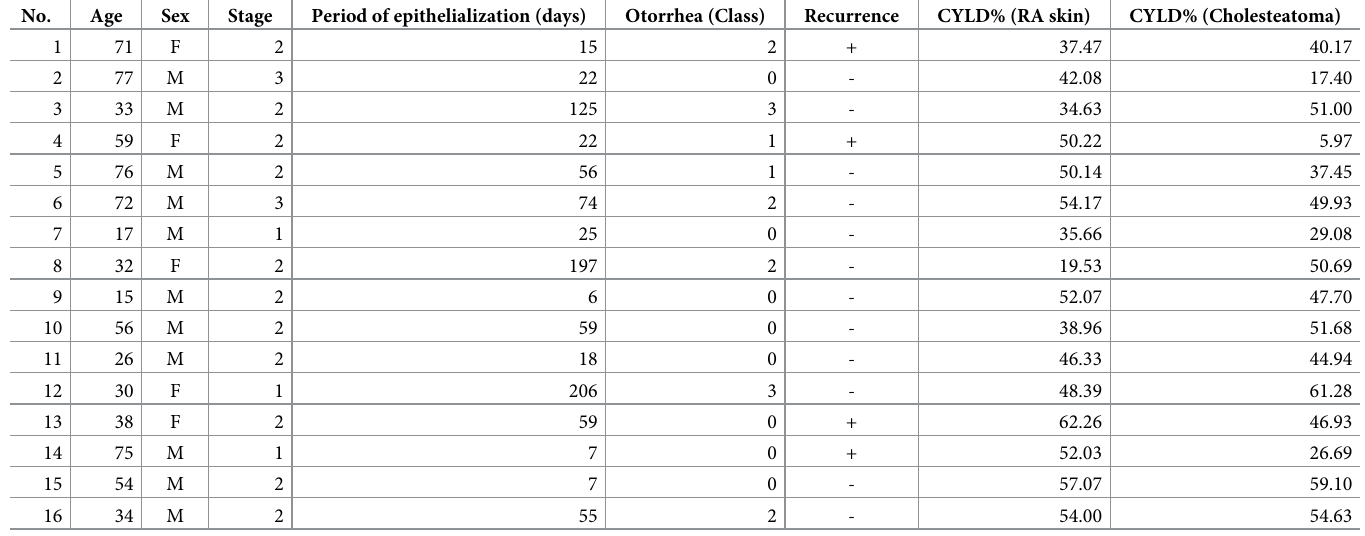
Table 1. Clinical data of 16 patients with acquired